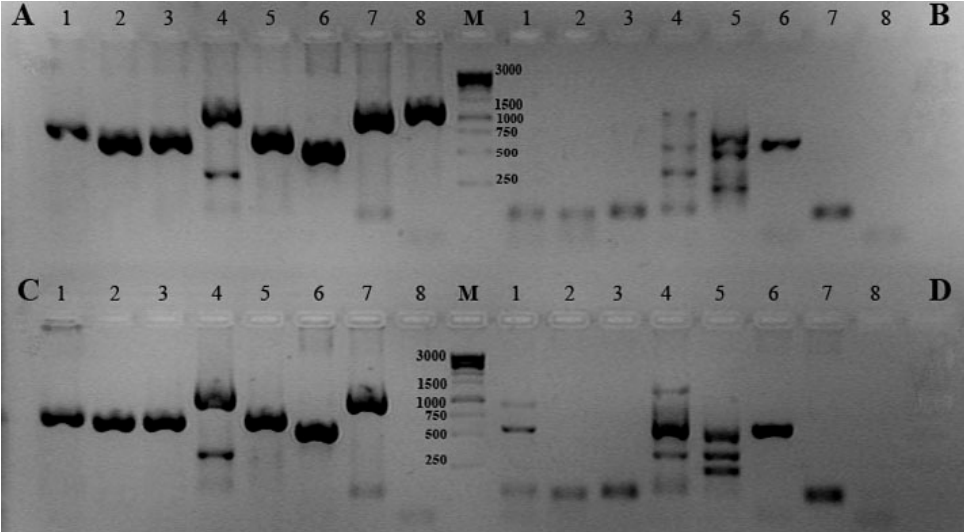
Figure 1. Gel-electrophoresis of PCR products of the new molecular markers: ( A ) C. amphilecti KMM 1561 T , C. amphilecti KMM 296 and KMM 7516; ( B ) C. marina LMG 2217 T and KMM 6284; ( C ) C. litoralis KMM 3880 T , KMM 7000, KMM 7005 and KMM 7514; ( D ) C. pacifica KMM 3879 T , KMM 6731, 7505, 7508, 7515, 6816, and 6818. Lane numbers: 1 —DNA/RNA non-specific endonu-